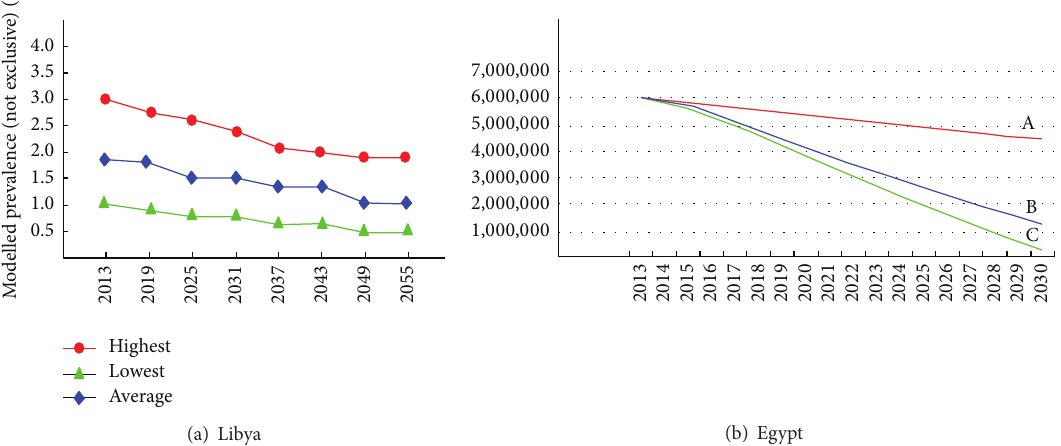
Figure 3: The impact of prevention and treatment on future prevalence rates of HCV. Modeled prevalence of hepatitis C virus infection Libya and Egypt. A: number of HCV-infected cases. B: number of cases after prevention. C: number of cases after prevention and